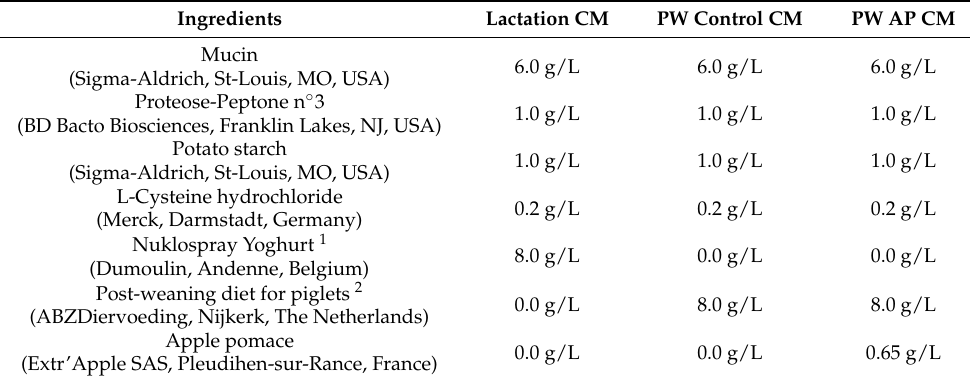
Table 1. Composition of the culture media.